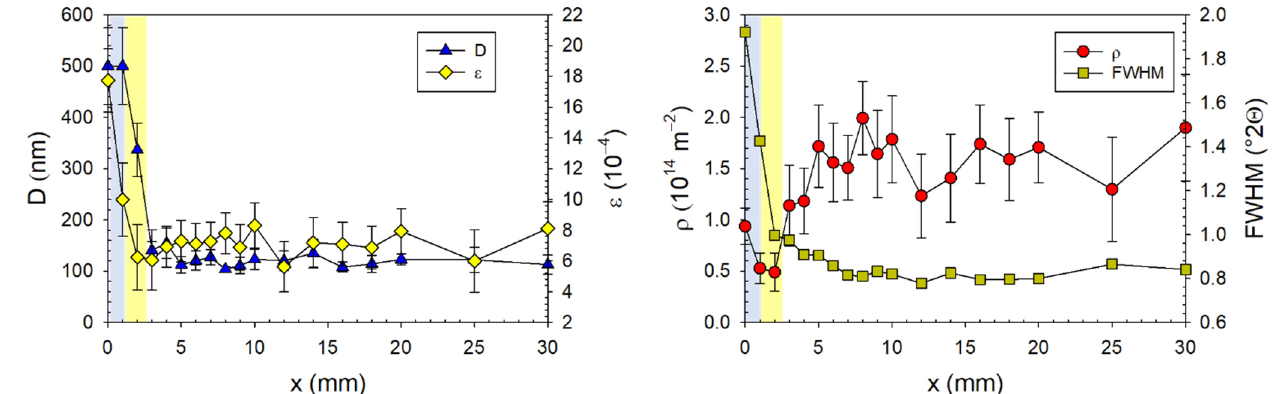
Figure 5. Dependence of FWHM parameter, crystallite size D , microstrain ε , and dislocation density ρ on the distance from the weld axis. The blue and yellow areas denote the position of the WM and HAZ, respectively.